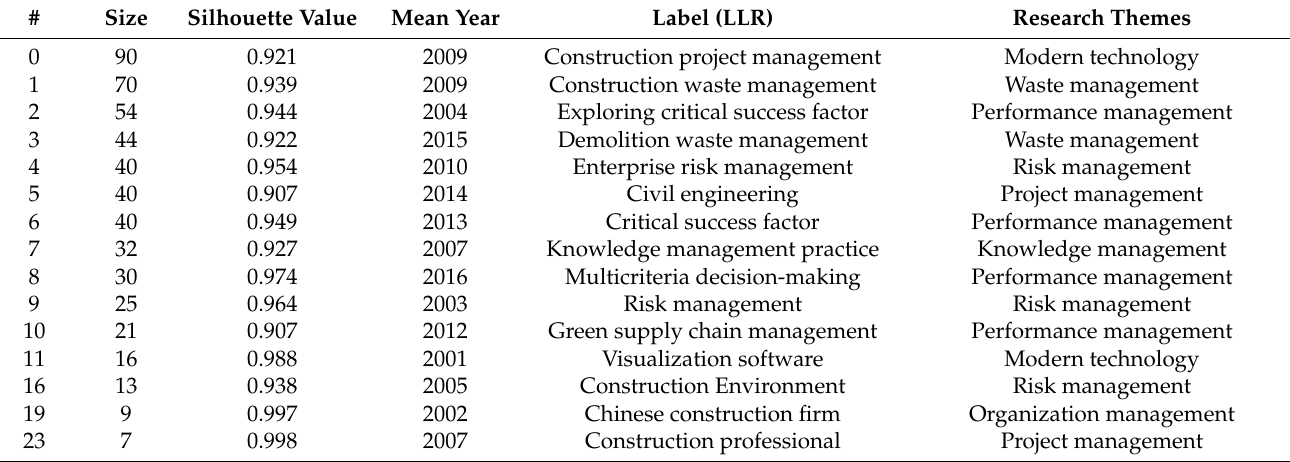
Table 4. Fifteen major clusters of co-cited reference.